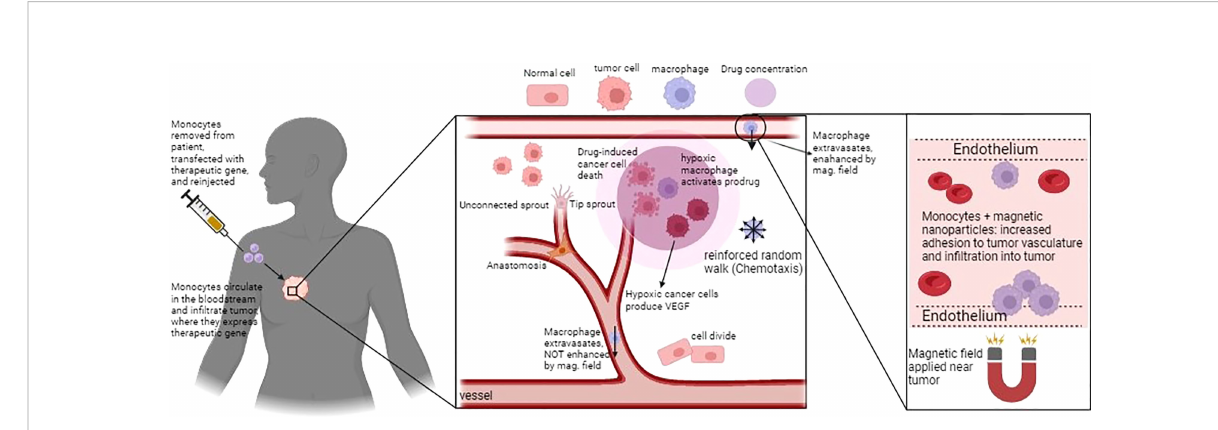
FIGURE 2 Schematic fi gure of macrophage-based cancer therapy and the corresponding mathematical model in Owen et al., (70). Macrophages can in fi ltrate and activate a pro-drug within the hypoxic region of tumor. The loaded macrophages, guided by the external magnetic fi eld, extravasate in the tumour microenvironment to release their anti-tumoural action, Figure reproduced from reference